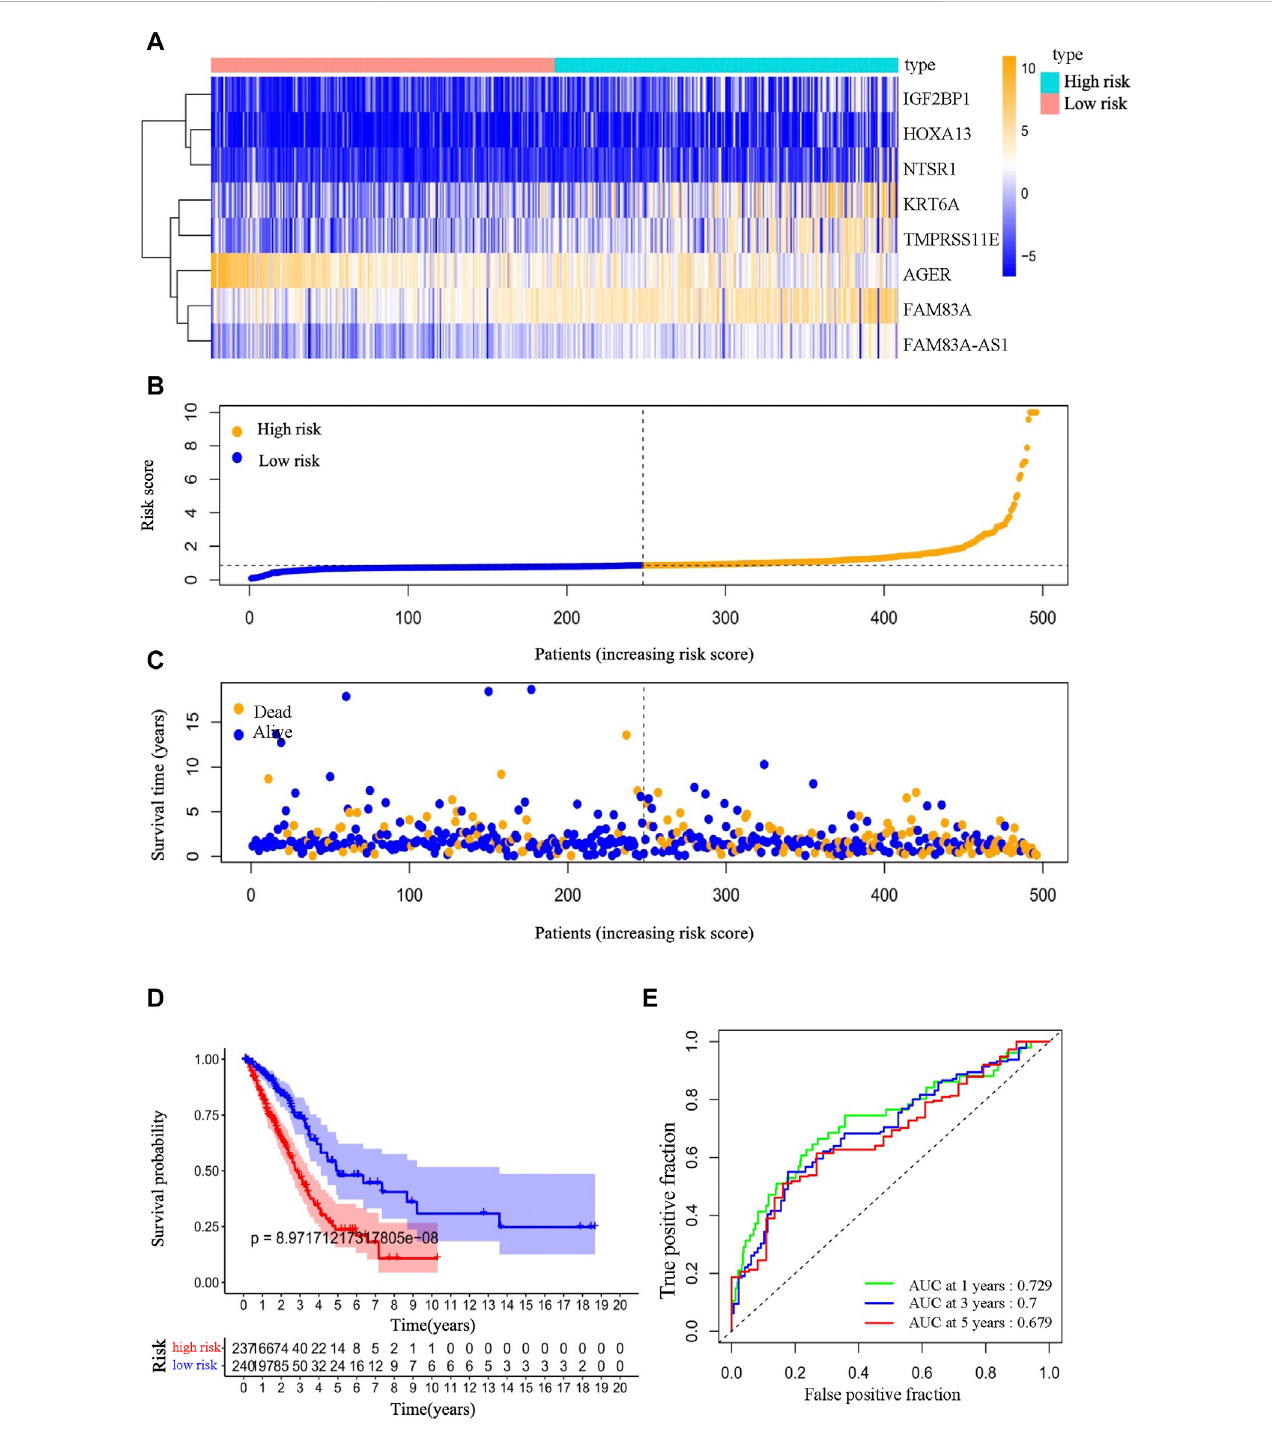
FIGURE 3 Prognostic values of EMT-LUAD related genes in our prediction model for LUAD patients. (A) Expression difference heatmap of the eight EMT-LUAD related genes with independent signi fi cant prognostic value for all individuals in the high- and low-risk groups. (B) Risk score curve of all included LUAD patients. (C) Survival status of all included LUAD patients [In (B,C) , the scatter represents an individual; the x -axis ranks individuals according to the risk scores from highest to lowest; the dotted line inthe centerof theplotrepresents the individuals with themedian risk score]. (D) Survivalcurvesof thehigh- and low-risk groups. (E) 1-year, 3-year and 5-year time-dependent ROC curve of our prediction